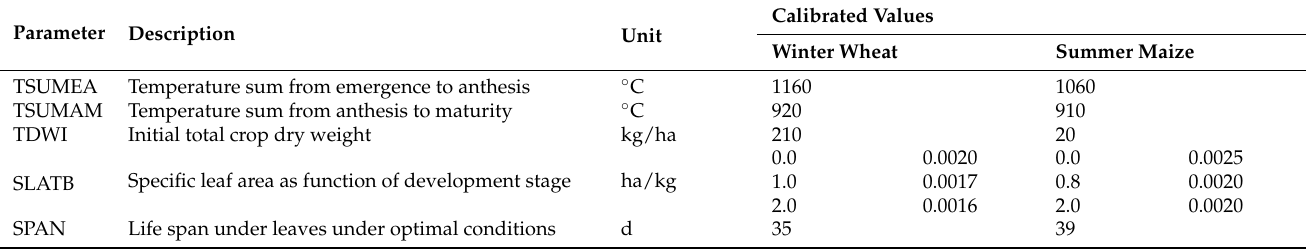
Table A3. Crop parameters for wheat and